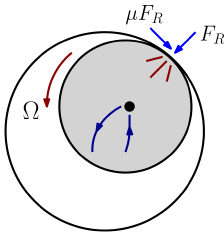
Figure 3. Single-point rotor–casing rub. One rotor spot impacts one point on the casing at a time. During the contact, normal and friction rub forces (light blue) change the rotor orbit direction (dark blue) and inflict vibration in the